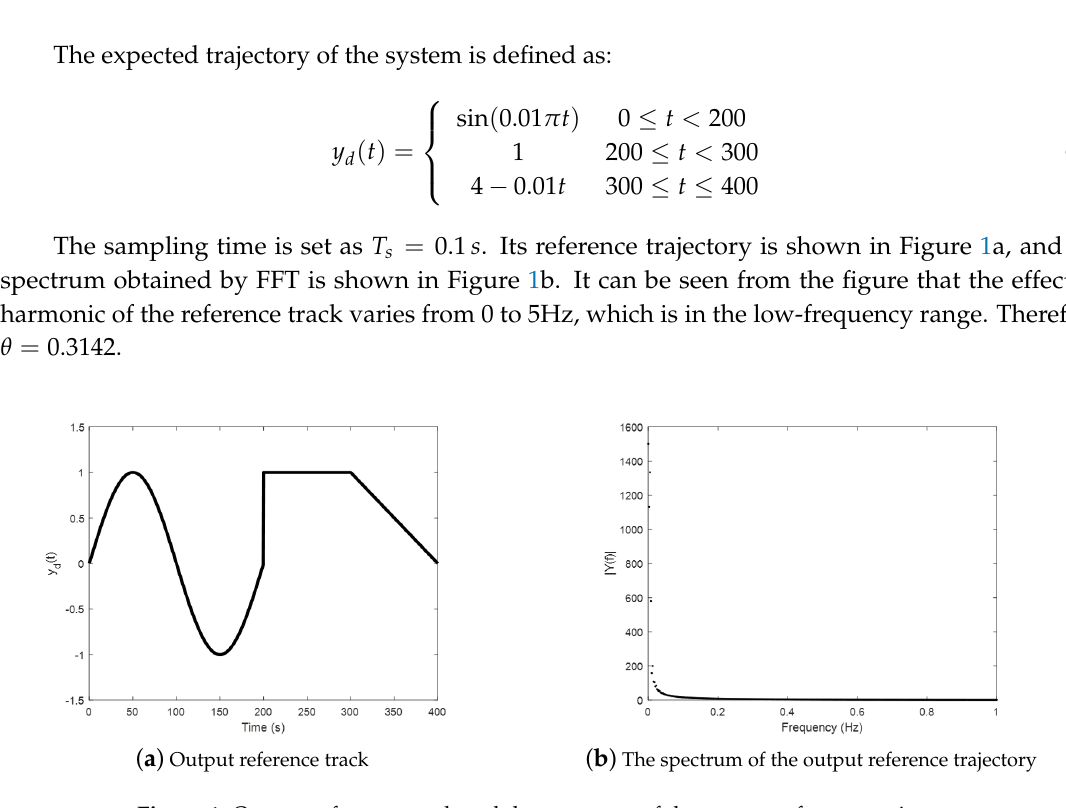
Figure 1. Output reference track and the spectrum of the output reference